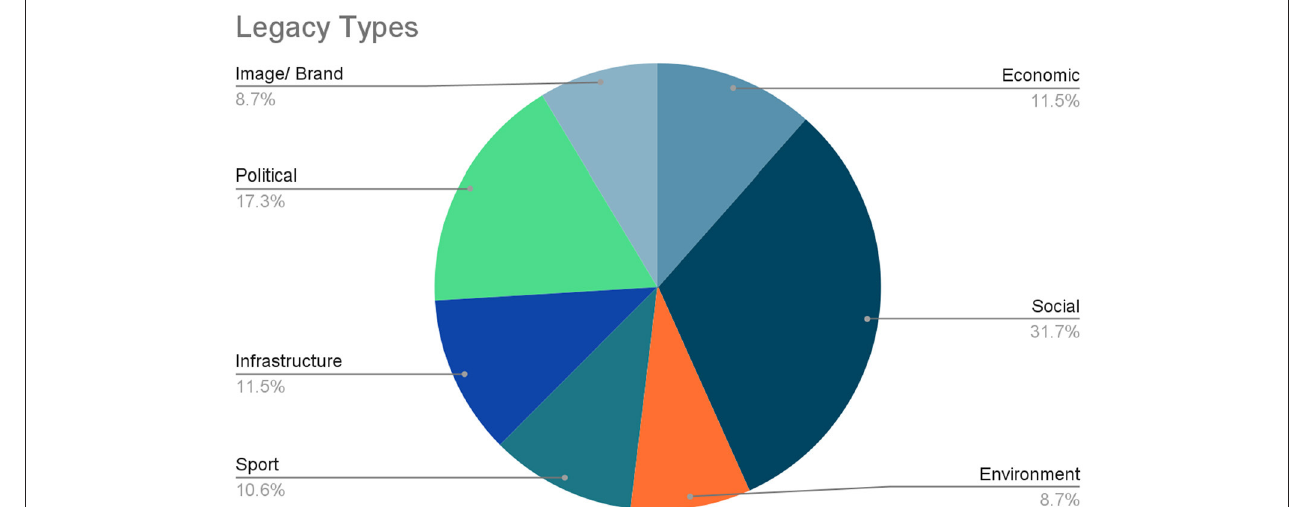
FIGURE 4 | Legacy